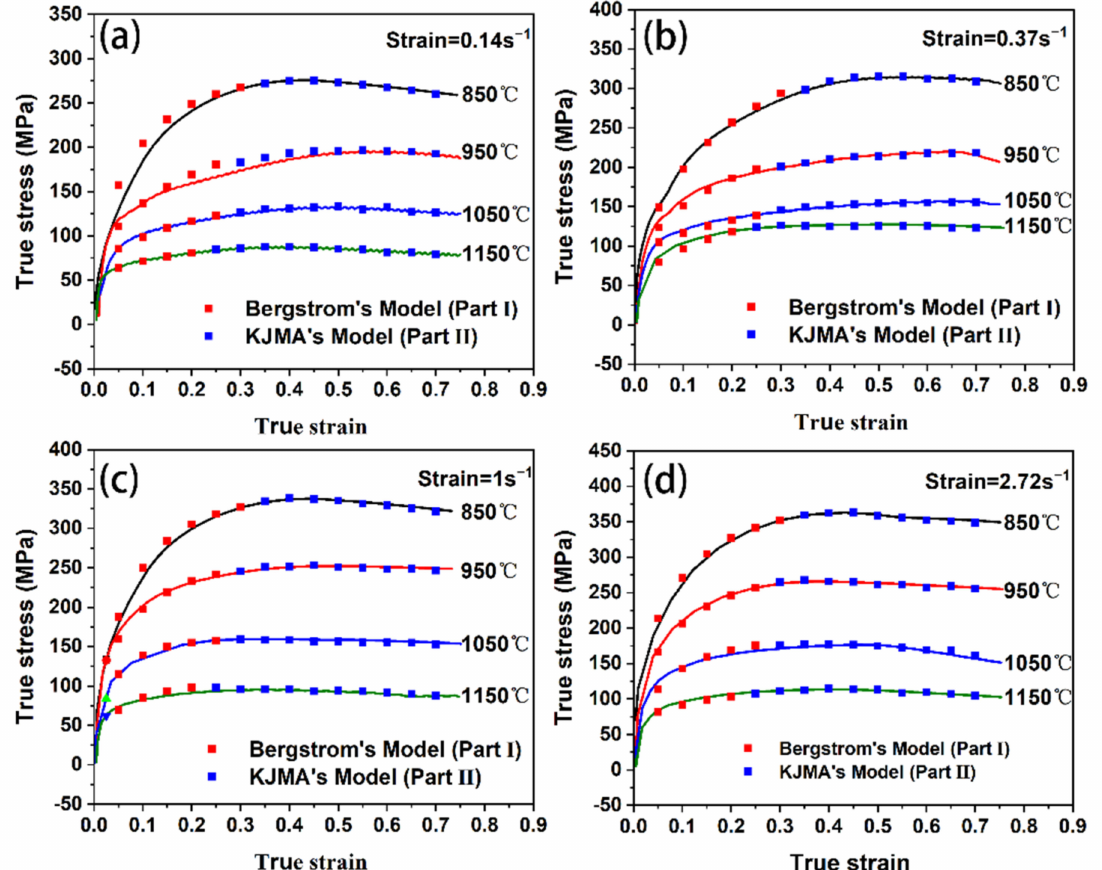
Figure 8. Comparison between the experimental and with Bergstrom and KJMA models at differ- ent strain rates (symbols for the predicted flow stress; the solid line for the experimental results), ( a ) 0.1 s − 1 , ( b ) 0.37 s − 1 , ( c ) 1 s − 1 , and ( d ) 2.271 s − 1